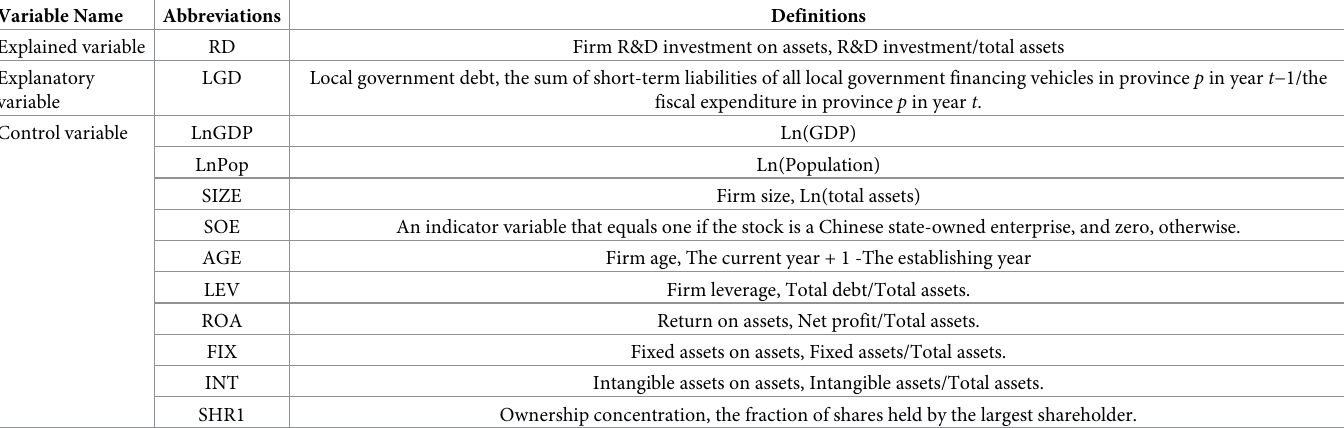
Table 1. Variable definitions.